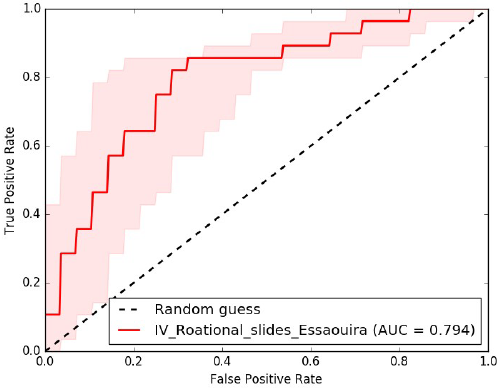
Figure 13. ROC curves of the susceptibility model for rotational slides (AUC =